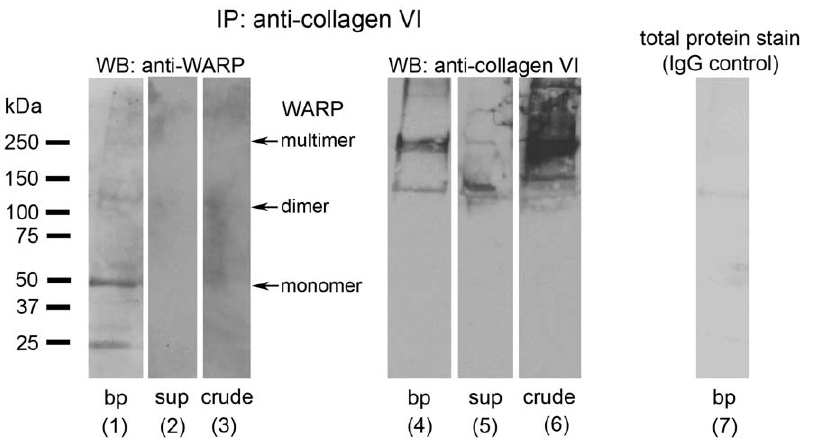
Figure 7. WARP co-precipitates with collagen VI. Collagen VI was isolated from cartilage extracts using magnetic beads. Following magnetic bead separation, total lysate, supernatant and pellet fractions were immunoblotted using antibodies against WARP and collagen VI. Fractions containing crude isolate (lanes 3 and 6), magnetic bead-isolated collagen VI (lanes 1 and 4), and supernatant remaining following collagen VI precipitation (lanes 2 and 5) were subjected to SDS-PAGE and immunoblotted using sheep anti-WARP antiserum (lanes 1 to 3) or anti-collagen VI antibodies (lane 4 to 6). WARP was present in collagen VI-precipitated material but not the supernatant indicating that both WARP and collagen VI are present in suprastructures. A control demonstrating that virtually no material is isolated by normal mouse serum coupled to magnetic beads is shown in lane 7 (total protein stain of blot membrane). Under reducing conditions WARP migrates as a 50 kDa monomer and the a 1 and a 2 chains of collagen VI co-migrate at approximately 200 kDa. Molecular weight marker (kDa) is shown on left. bp, bead pellet; sub, supernatants; crude, crude extract.